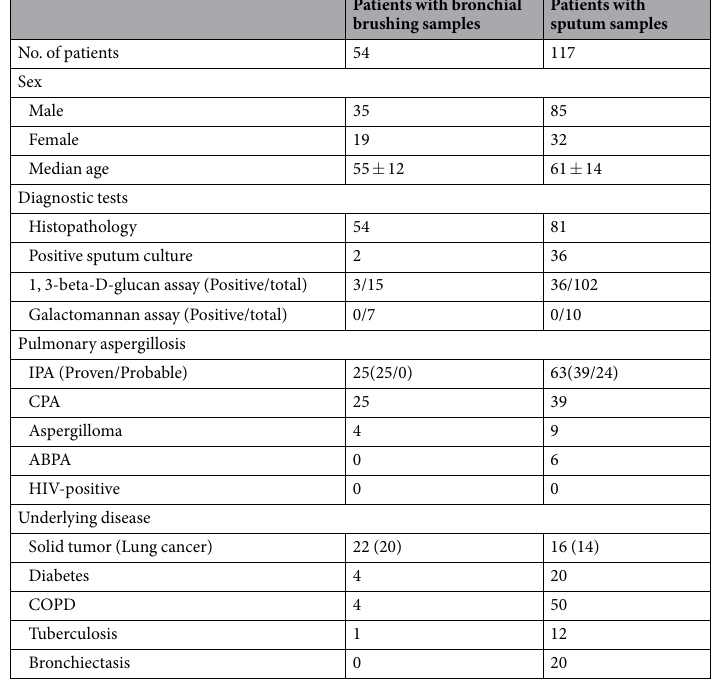
Table 1. Clinico-demographic data on patients. Values are N, or mean ± SD. ABPA: